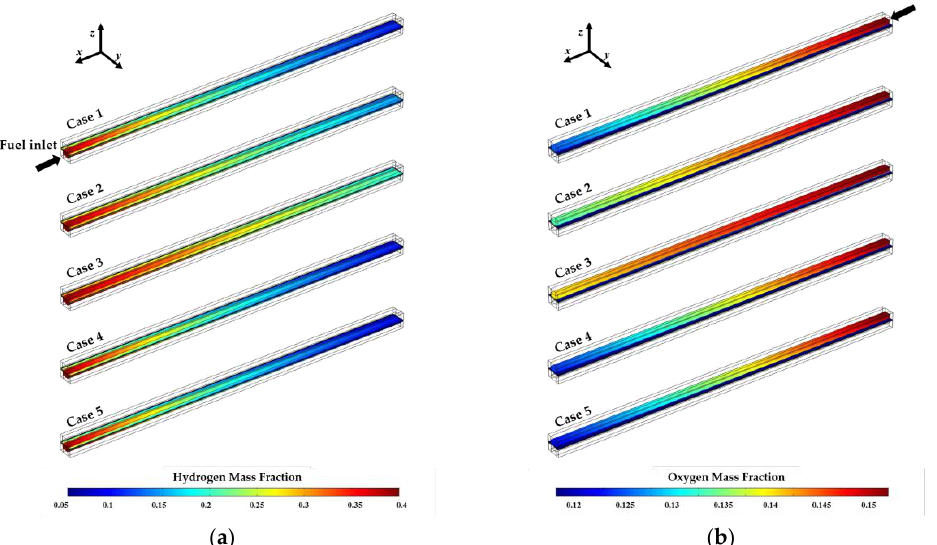
Figure 4. Three-dimensional gas species distribution: ( a ) hydrogen mass fraction for the anode and fuel channel; and ( b ) oxygen mass fraction for the cathode and air channel.